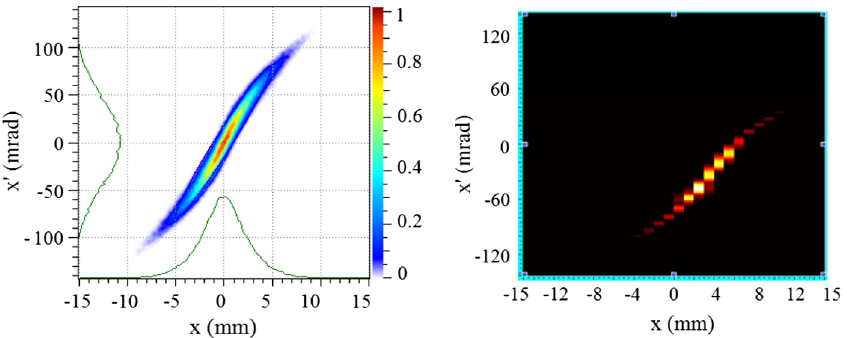
FIG. 4. Beam phase space at the measured location (8.8 cm drift downstream of the LEBT exit): simulation results (left) and measurement results